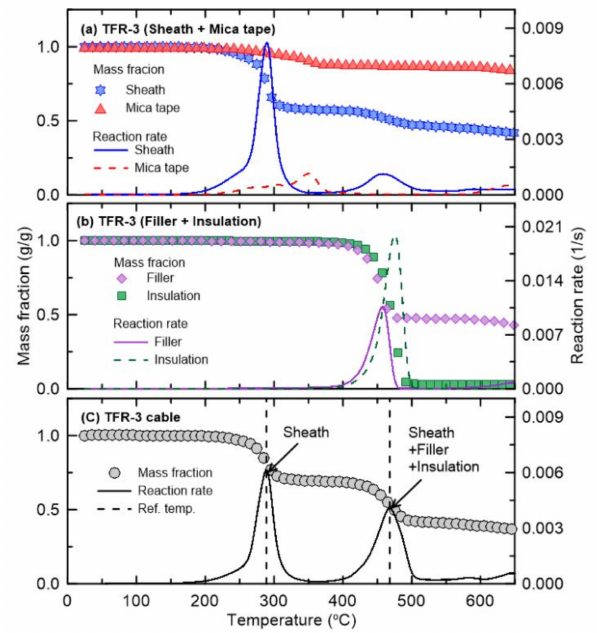
Figure 3. Comparison of mass fraction and reaction rate as a function of temperature for TFR-3